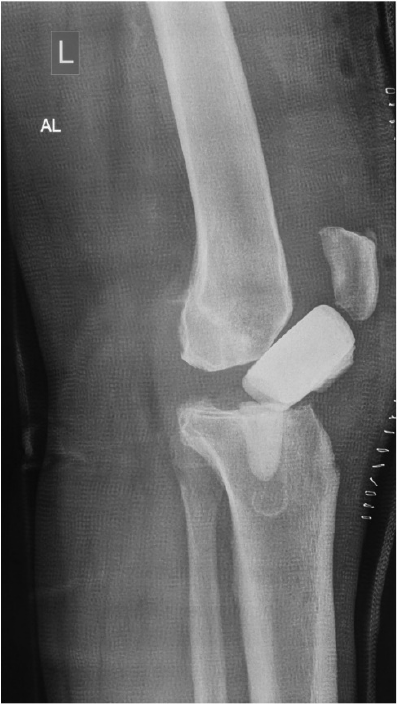
Figure 7: Lateral radiographs of a left knee joint showing a fracture with subsequent dislocation of a static spacer one week after implantation.